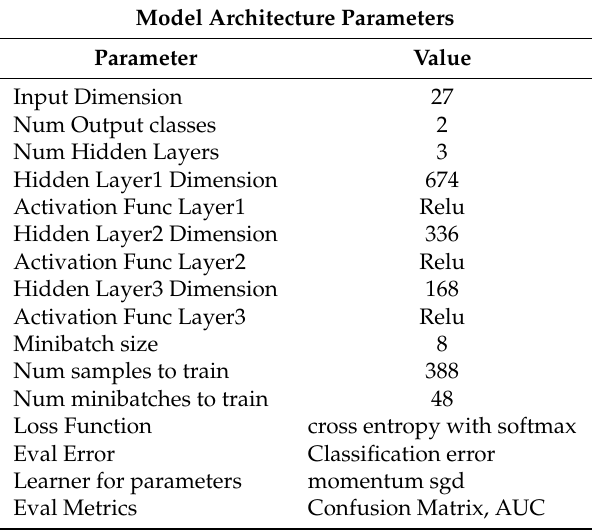
Table 3. Model architecture